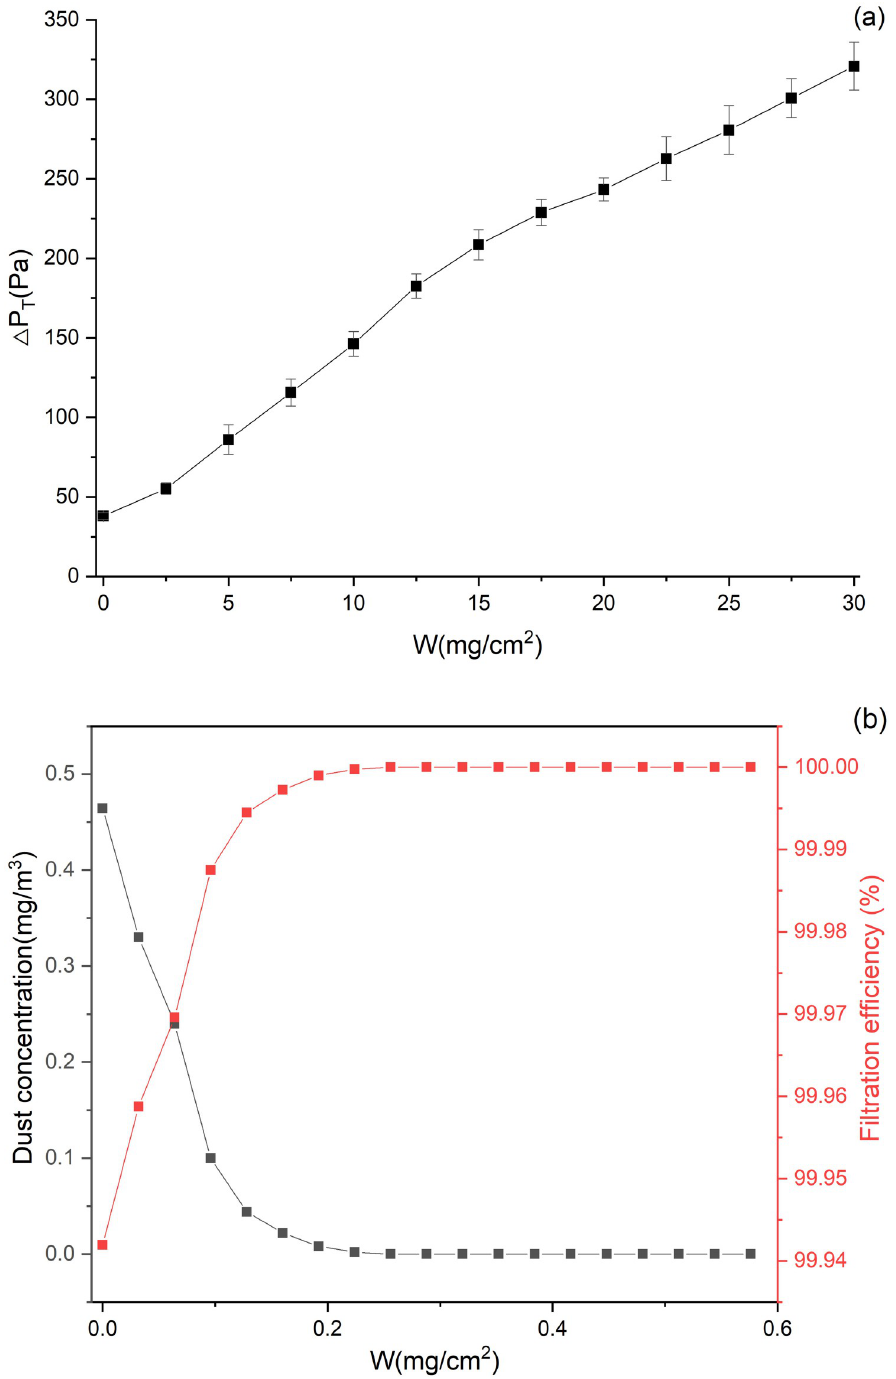
Fig 12. Variation of pressure drop and filtration efficiency of flat filtration during dust loading.